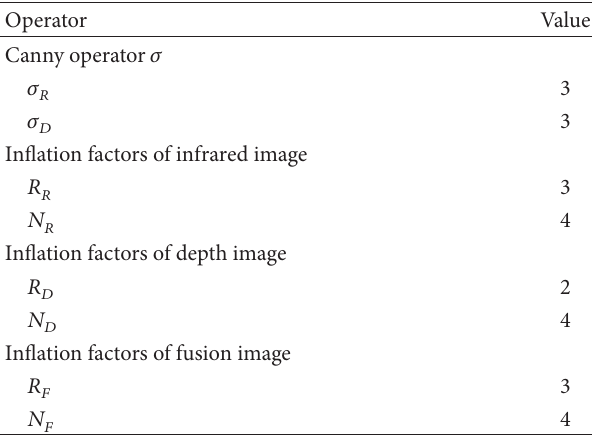
Table 1: Operator